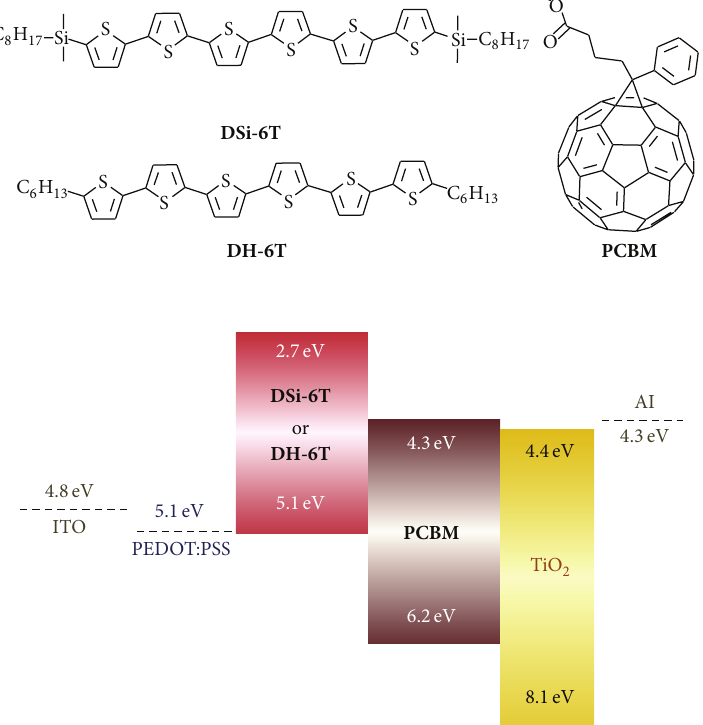
Figure 1: Chemical structures and energy band diagram of DSi-6T , DH-6T , and PCBM .